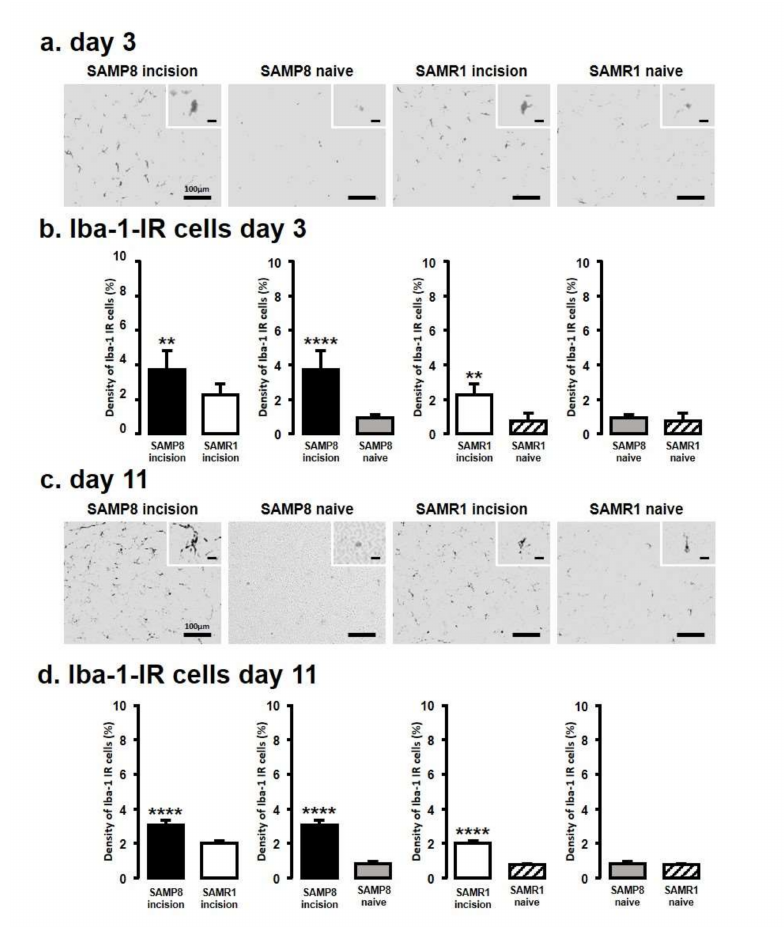
Figure 2. Microglial activation in Vc and C1 / C2 regions following palatal mucosal incision. Low